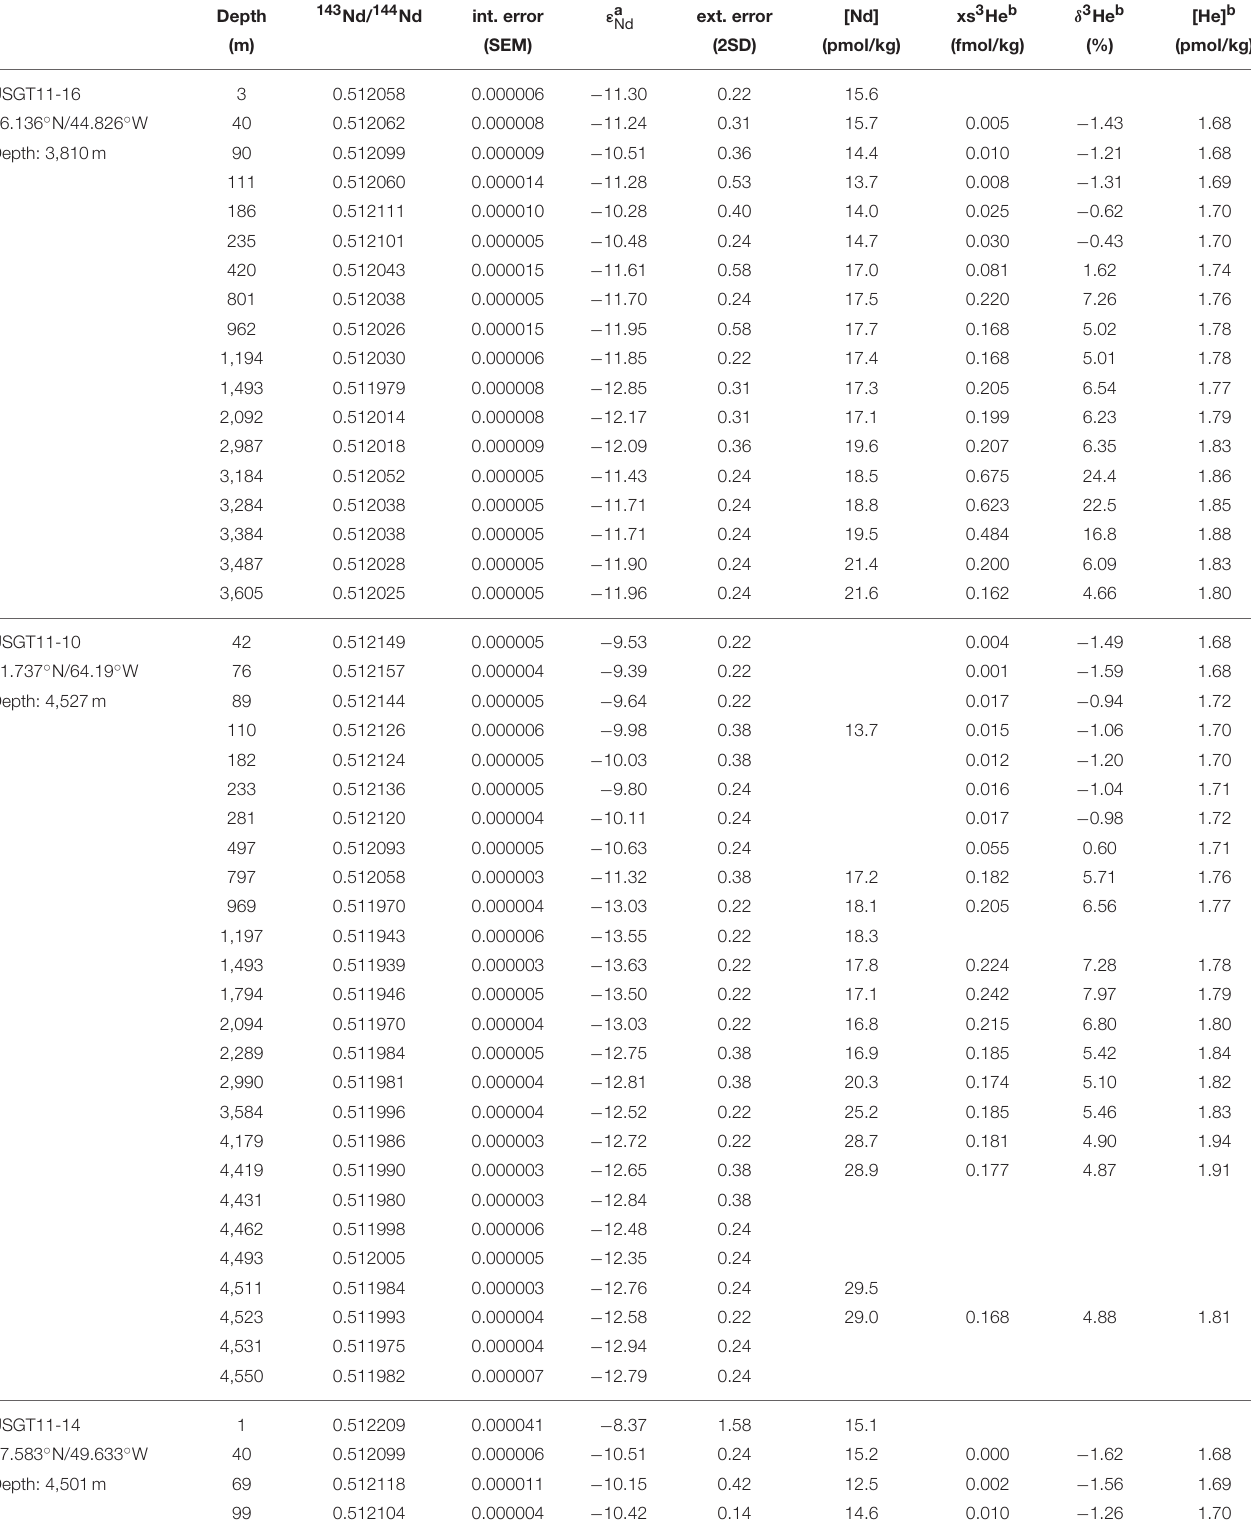
TABLE 1 | Vertical distribution of Nd isotopic composition and concentration, along with xs 3 He, δ 3 He and He concentrations of Jenkins et al.